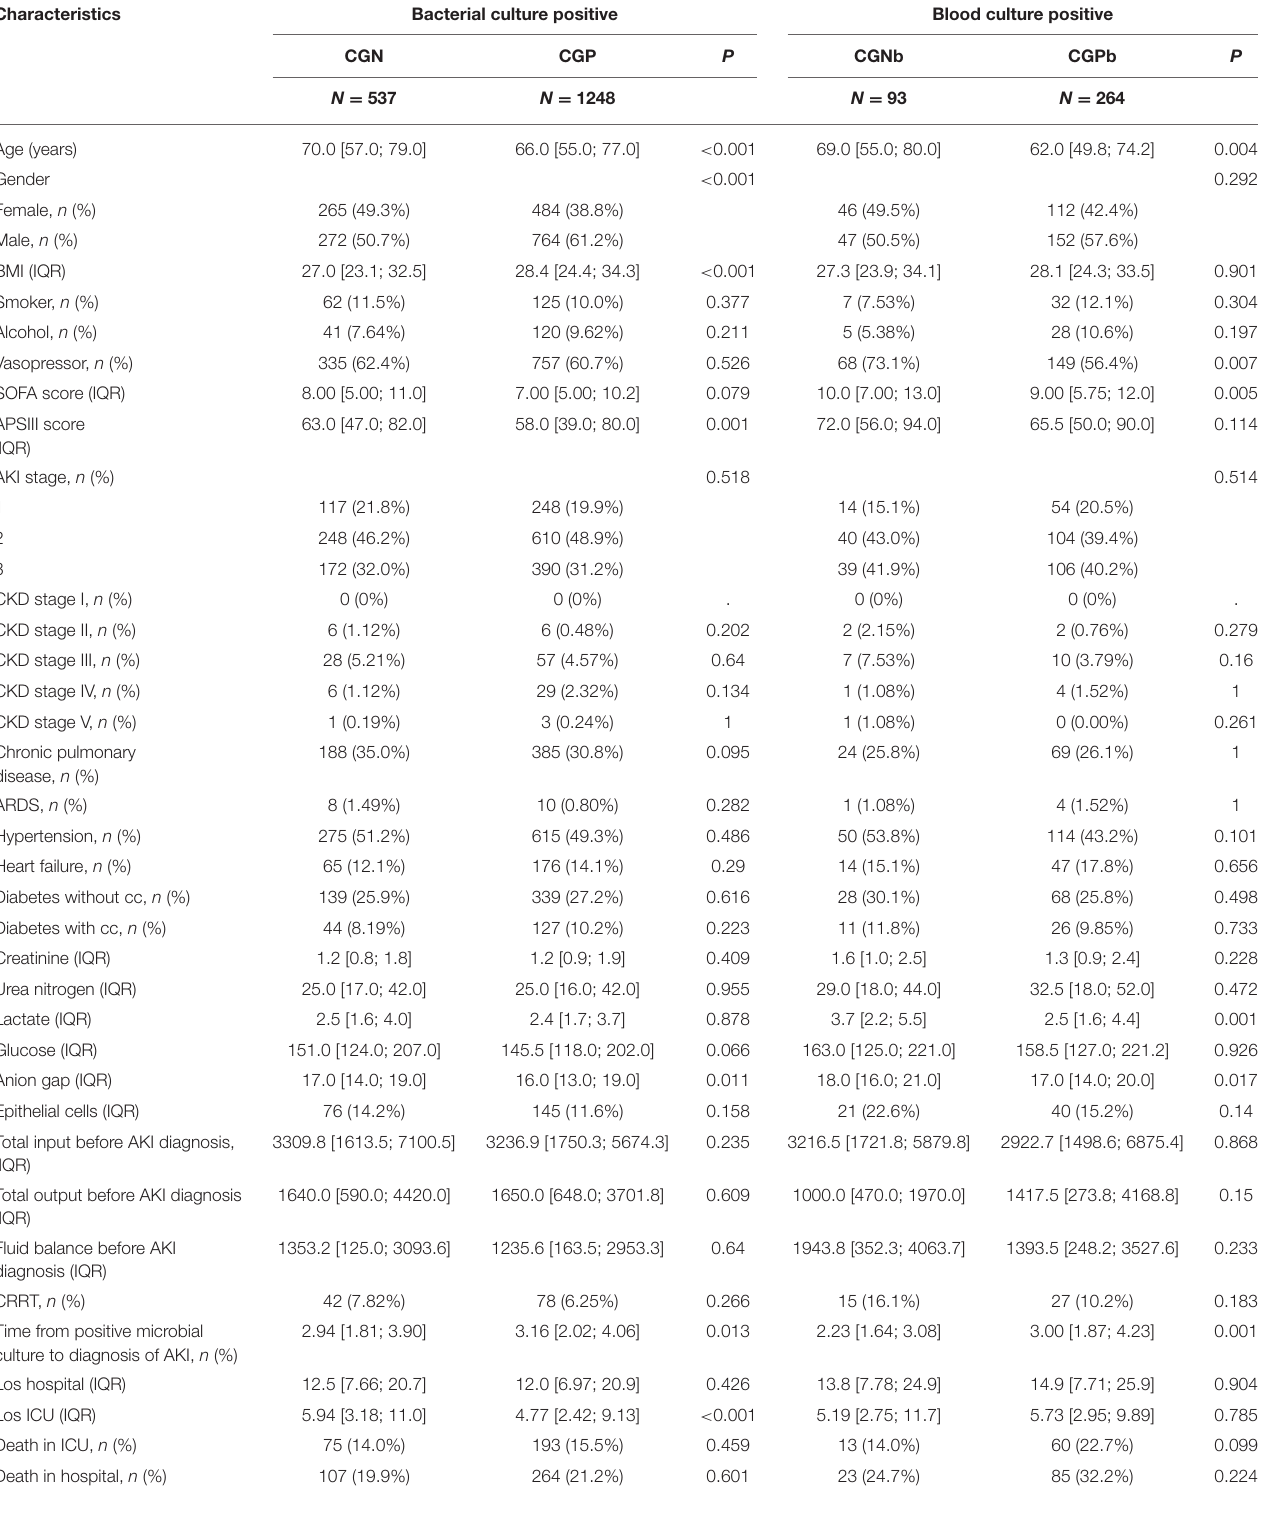
TABLE 1 | The baseline characteristics and clinical outcomes of patients with sepsis-associated acute kidney injury (S-AKI) among groups.